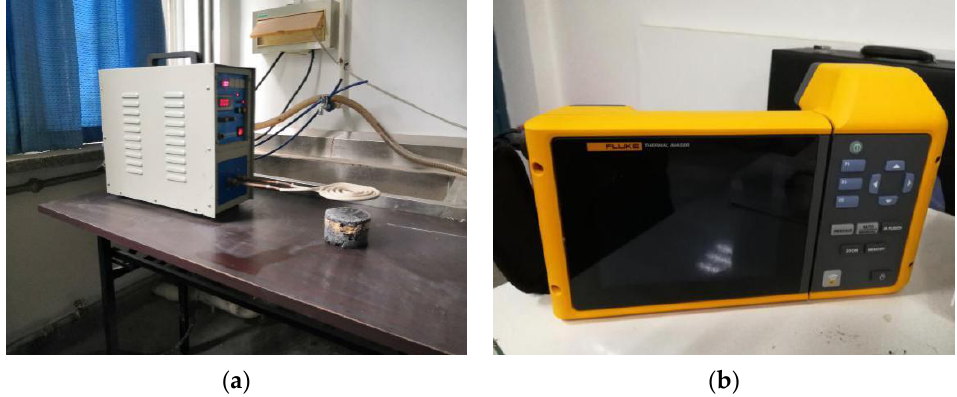
Figure 5. Test equipment. ( a ) Electromagnetic induction heater; ( b ) Tix520 infrared thermal device.